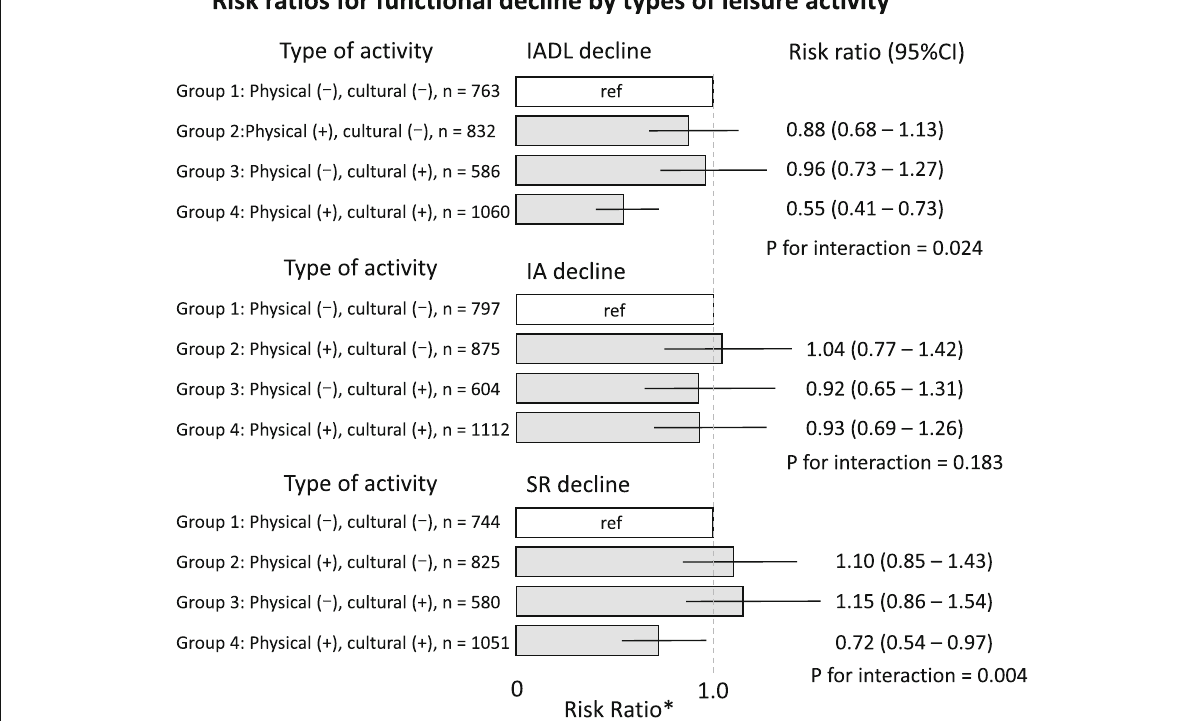
Fig. 2 Risk ratios for functional decline by types of leisure activity. IADL, instrumental activities of daily living; IA, intellectual activity; SR, social role. Error bars show 95% confidence intervals of the risk ratio. *Adjusted for baseline functional capacity and potential confounders such as age, gender, body mass index, smoking habit, ethanol intake, history of cancer cardiovascular disease, diabetes, hypertension, living alone, depressive symptoms, cognitive impairment, and participation to social activity. The relative risk for SR decline was adjusted for all confounders except for participation in social activity. † P values for interaction were based on the multivariable model which consist of the dependent variable (incidence of functional decline) and independent variables simultaneously including leisure physical activity, cultural leisure activity, interaction term, all confounding variables, and the number of leisure activity (< 2 vs. ≥